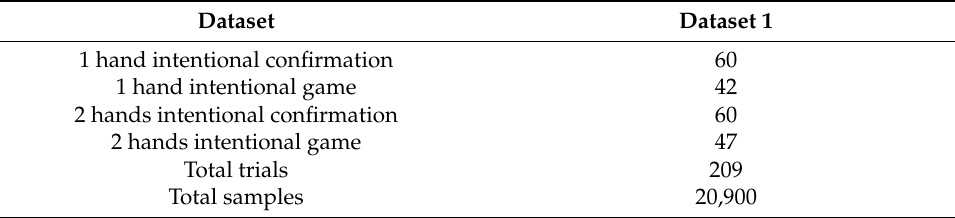
Table 4. Collected data on intentional clicks in the confirmation vs the game for Dataset 1.